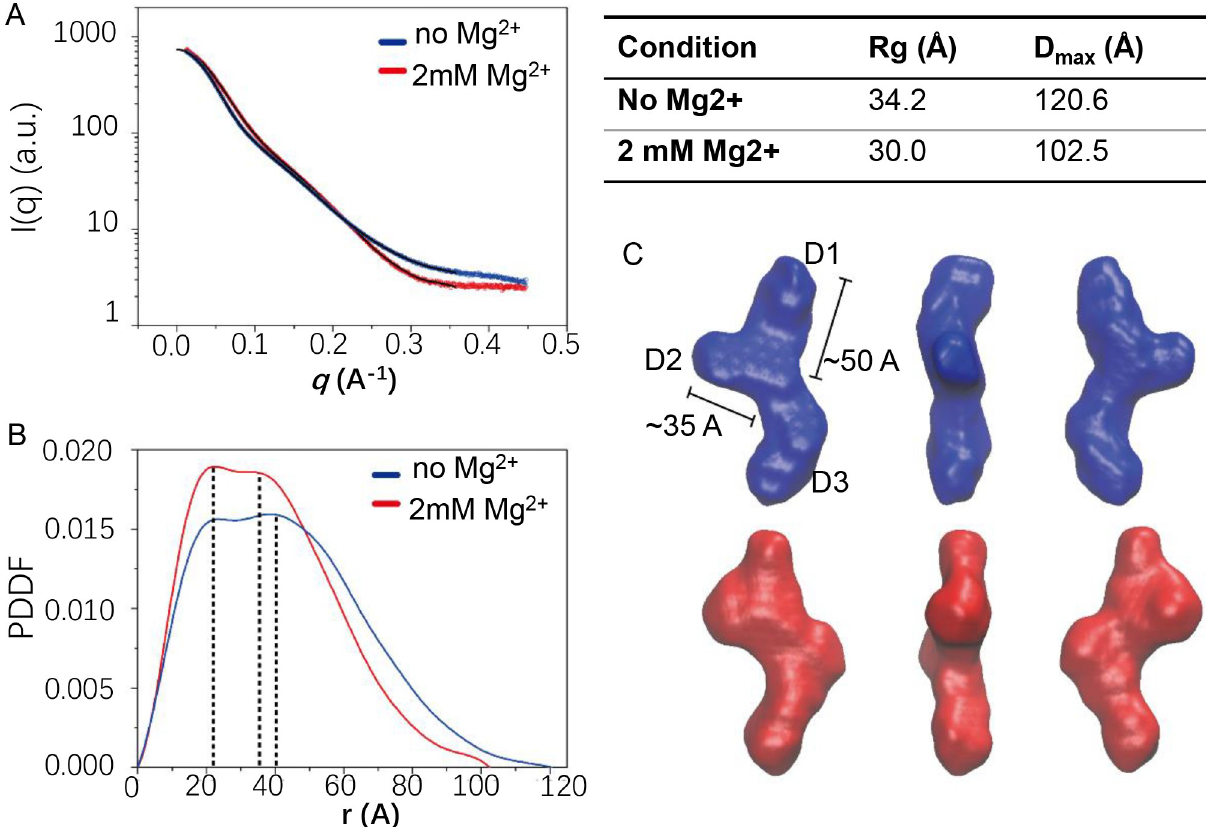
Fig 3. Small angle X-ray scattering (SAXS) analysis. SAXS indicates a tertiary folding of rpoS inhibitory stem as a three-way junction and Mg 2+ binding induces its conformational transition from a relatively relaxed structure to a compact one. (A) 1D scattering curves of rpoS inhibitory stem in the absence (blue) and presence (red) of 2 mM Mg 2+ . (B) The pair distance distribution function (PDDF) for 1D SAXS curves in (A). (C) 3D envelopes of inhibitory stem with (red) and without (blue) 2 mM Mg 2+ calculated using